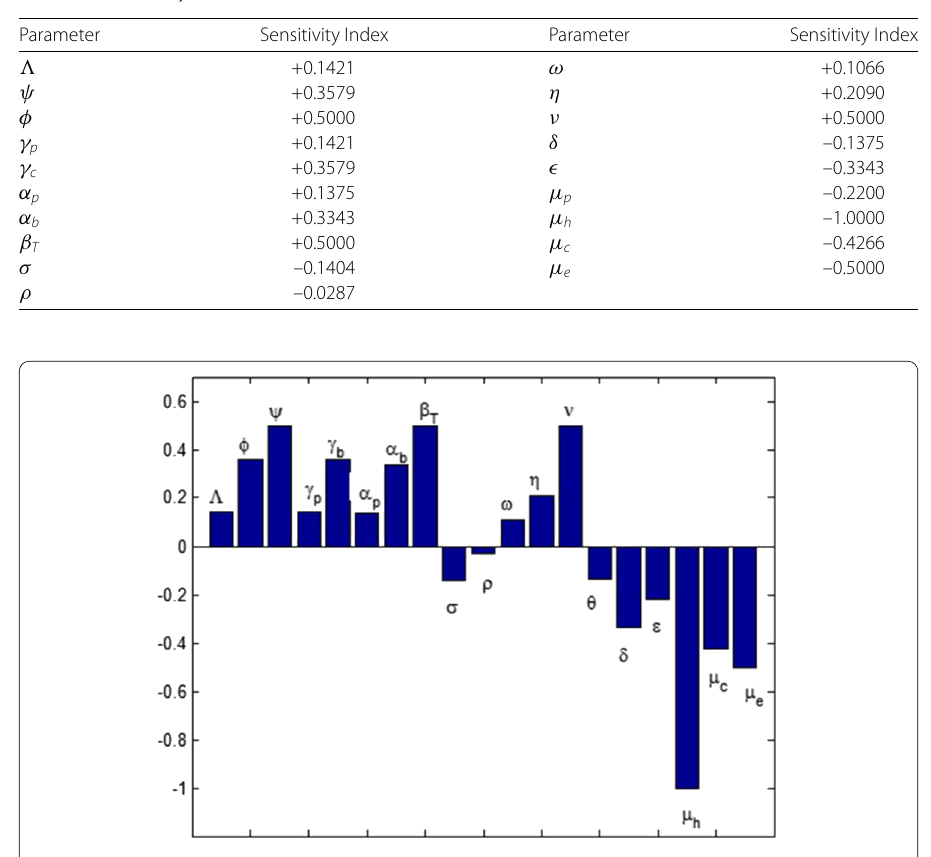
Figure 2 Graphical representation of sensitivity